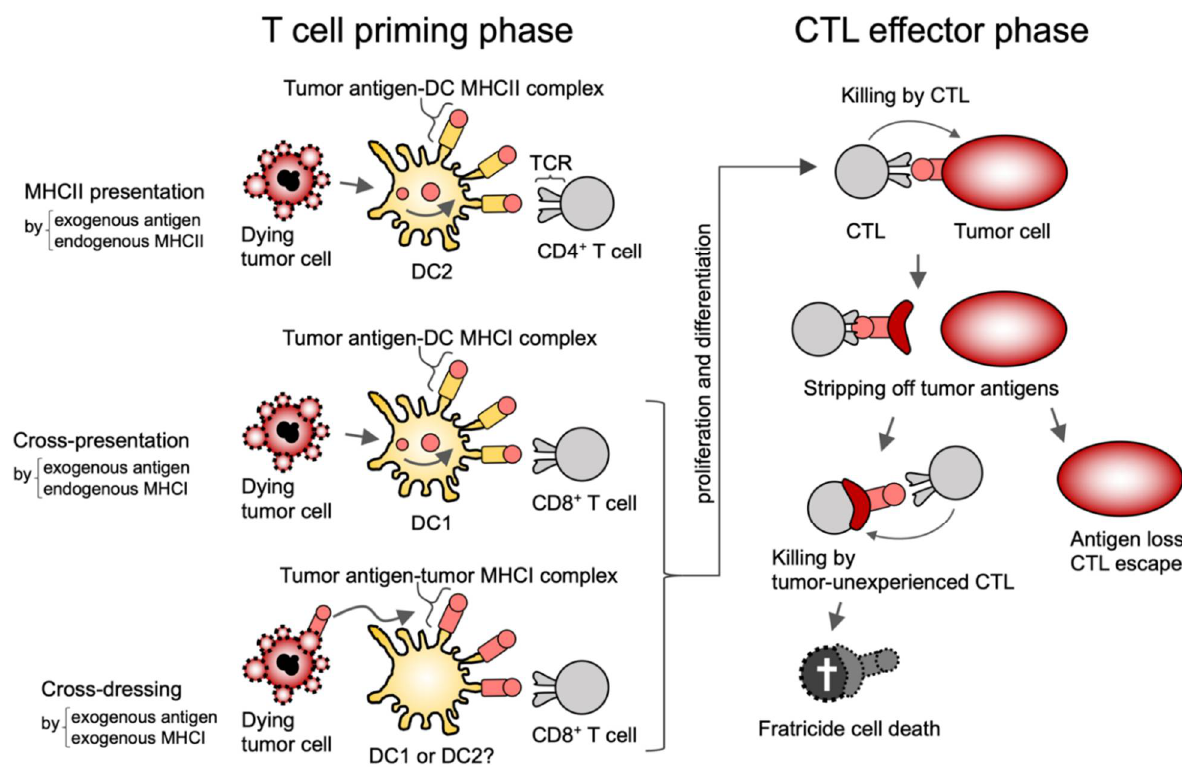
Figure 2. Trogocytosis in T cell priming and effector phases. During the priming phase, dendritic cell (DC) type 2 cells (DC2s) present extracellular tumor antigens on MHCII to activate CD4 + T cells whereas DC type 1 cells (DC1s) are able to present them on MHCI, called cross-presentation, to activate CD8 + T cells. In addition, DC1s and/or DC2s acquire preformed antigen-MHCI complexes for antigen presentation to CD8 + T cells, which is called cross-dressing. In the cytotoxic T lymphocyte (CTL) effector phase, CTLs strip off target antigens from tumor cells. These CTLs with acquired tumor antigen-MHCI are then lysed by tumor-unexperienced CTLs through a process called fratricide cell death. On the other hand, tumor cells lose antigens, resulting in generation of CTL escape variants.